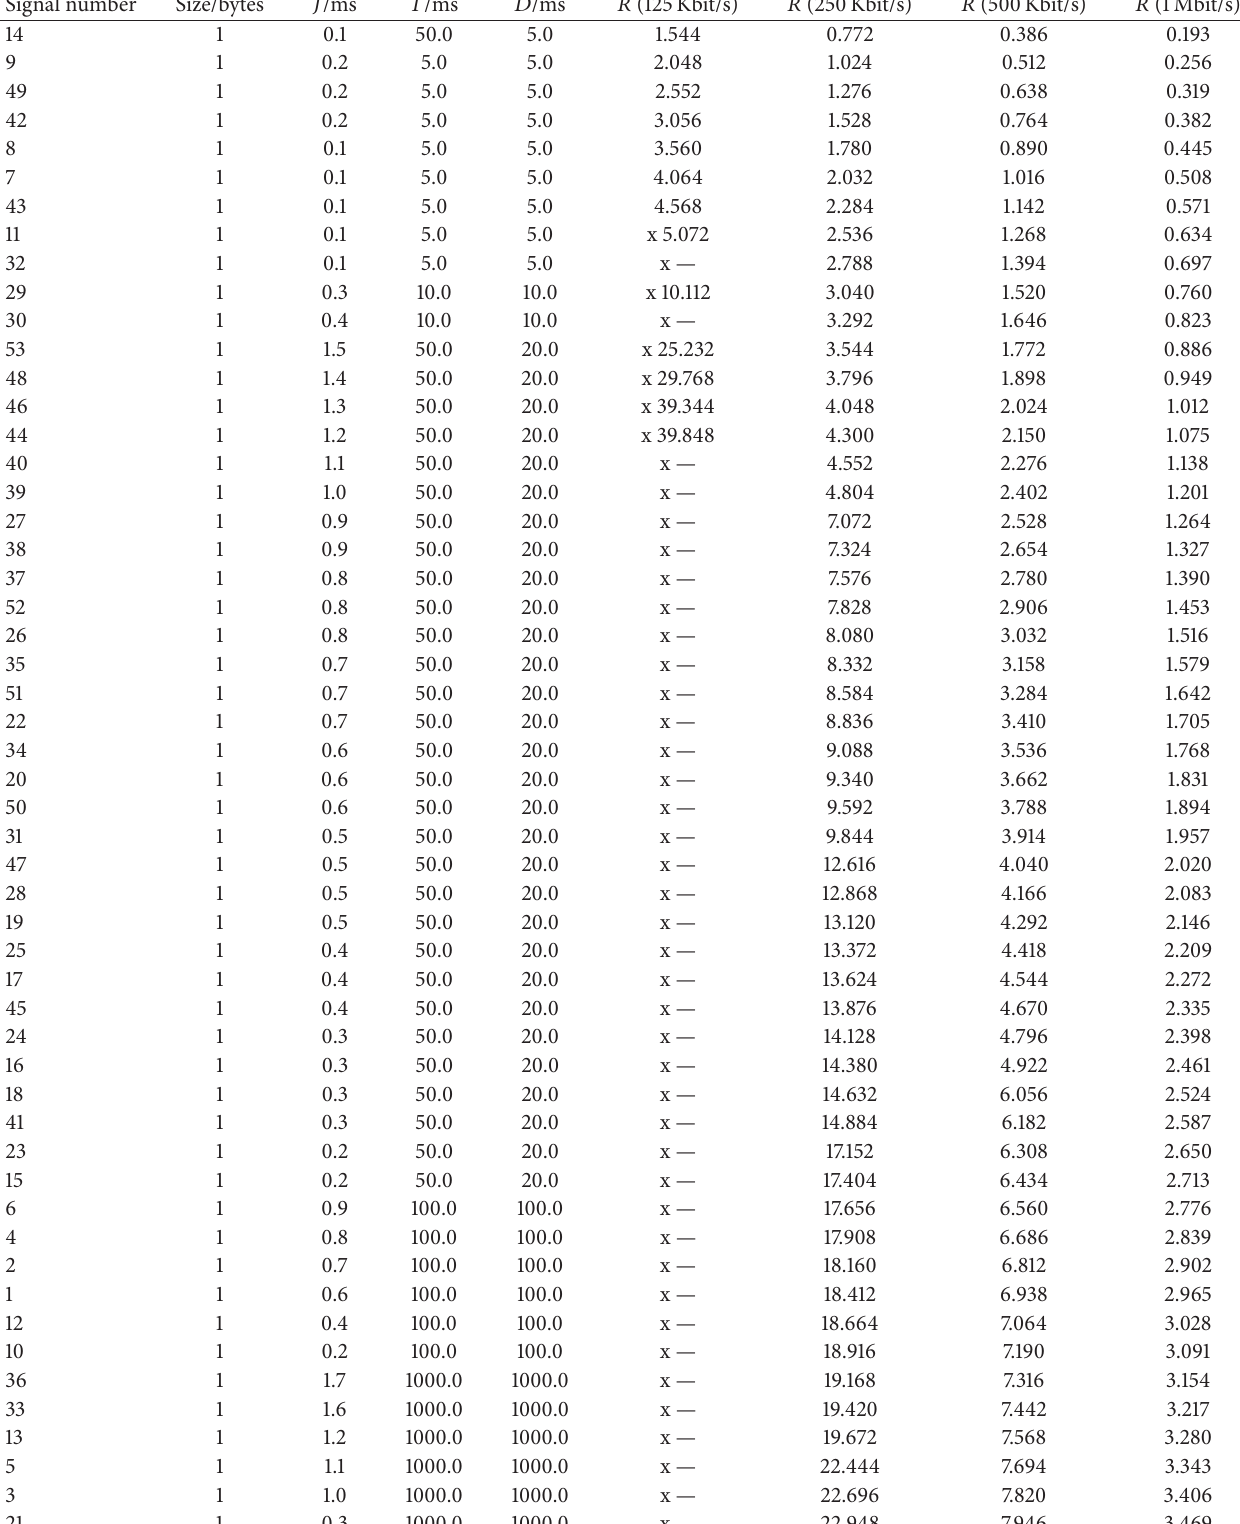
Table 1: CAN performance results